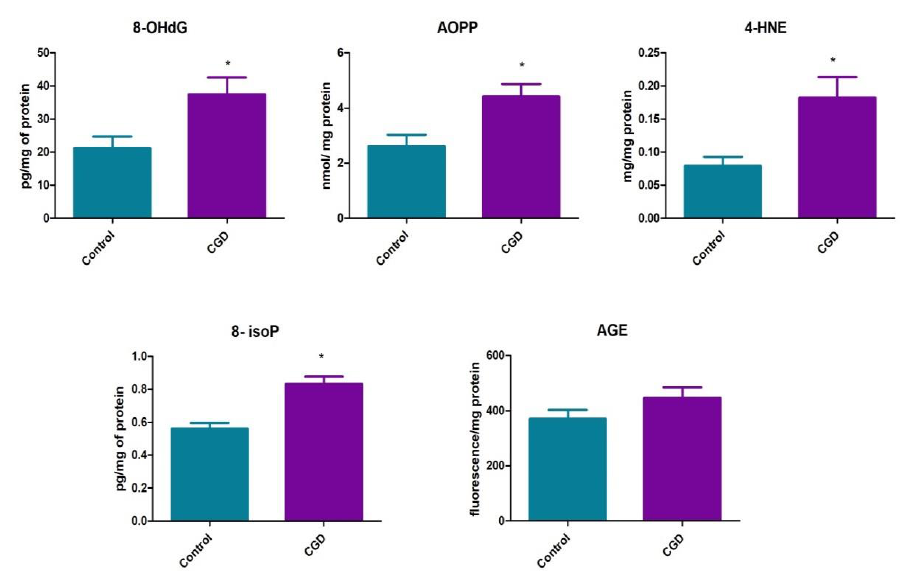
Figure 4. Lipid and DNA oxidation products in patients with CGD as well as healthy controls. 8-OHdG, 8-hydroxy-D-guanosine; AOPP, advanced oxidation protein products; 4-HNE, 4-hydroxynonenal; 8-isoP, 8-isoprostanes; AGE, advanced glycation end products. Differences statistically significant at * p < 0.05.